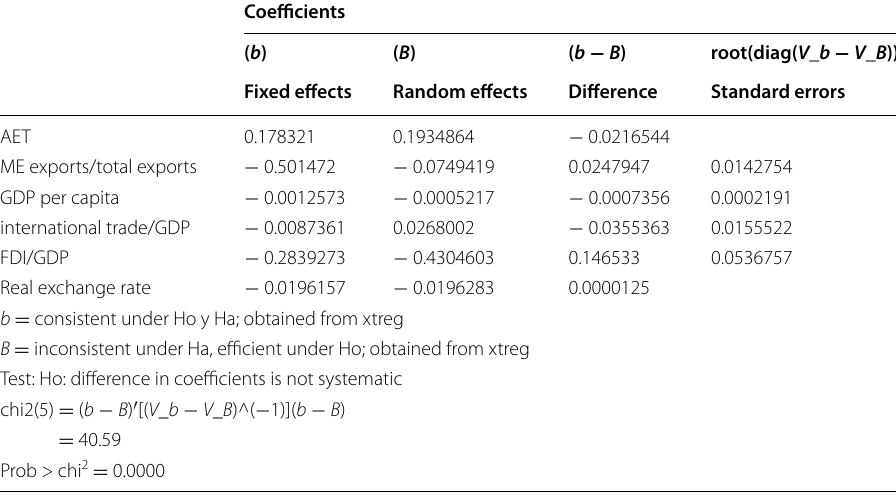
Table 11 Hausman test. Source : Author’s